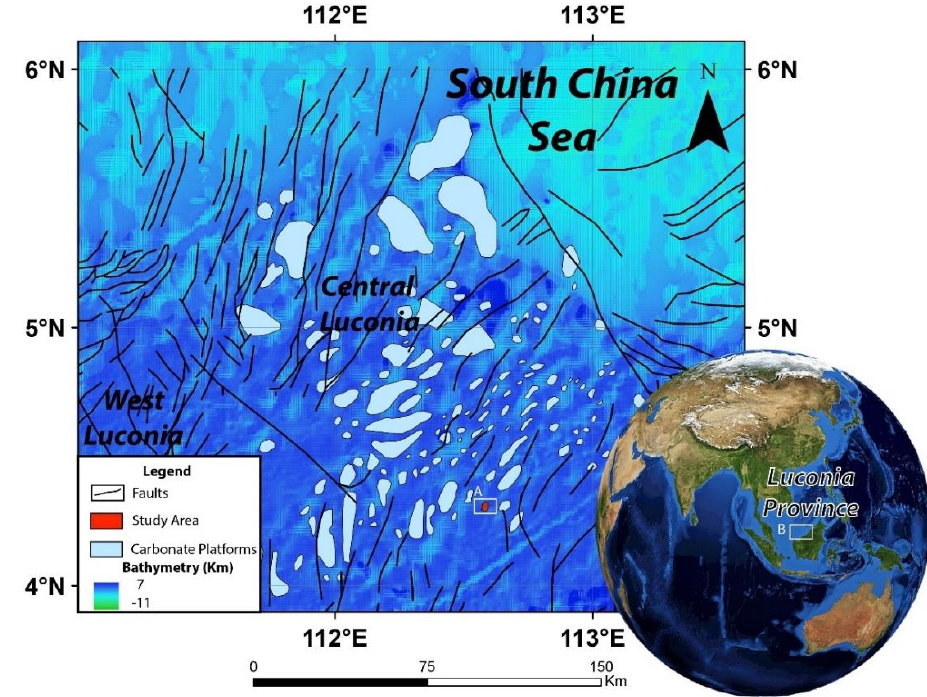
Figure 1. The location and bathymetry map of Central Luconia province and surroundings ( A ) in the white square, where the geology province is located, and in the red square, where the E11 field is located; ( B ) Central Luconia province geographic location.